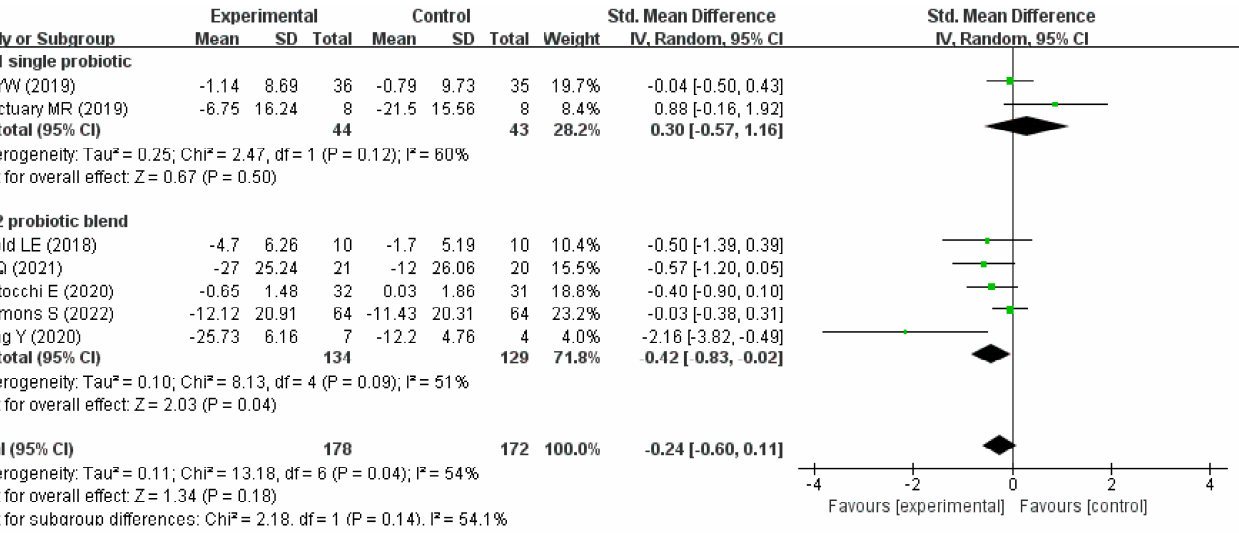
Figure 6. Forest plot for the subgroup analysis according to study type [23,25,27–30,32].